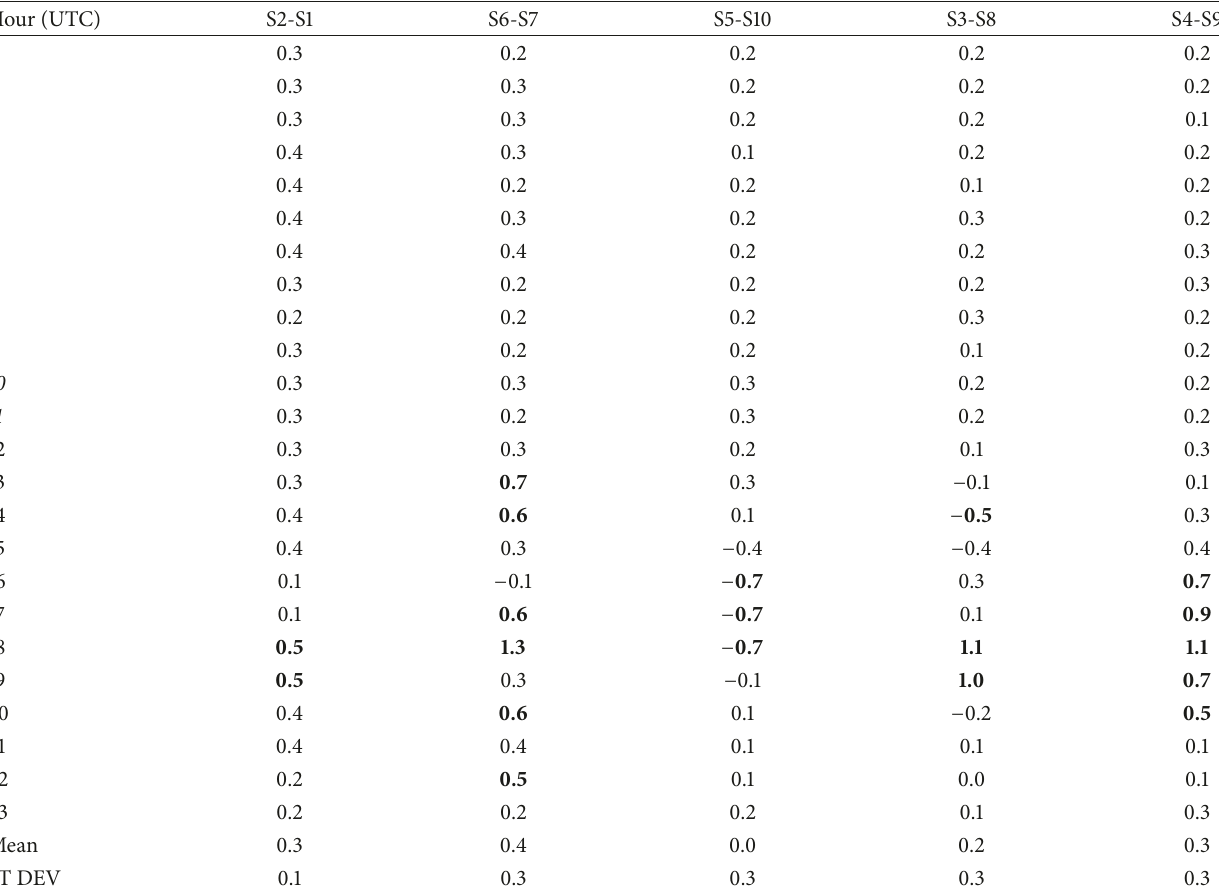
Table 5: Comparison of mean hourly 2-m minus 1-m temperature differences ( ∘ C) for 22–26 March 2015 at the five Tinytag sites. Differences ≥ ± 0.5 ∘ C are highlighted in bold. See Figure 1 and Table 1 for site details. Hours with nocturnal observations are highlighted in italic (https://www.timeanddate.com/sun/chile/santiago), here illustrated in